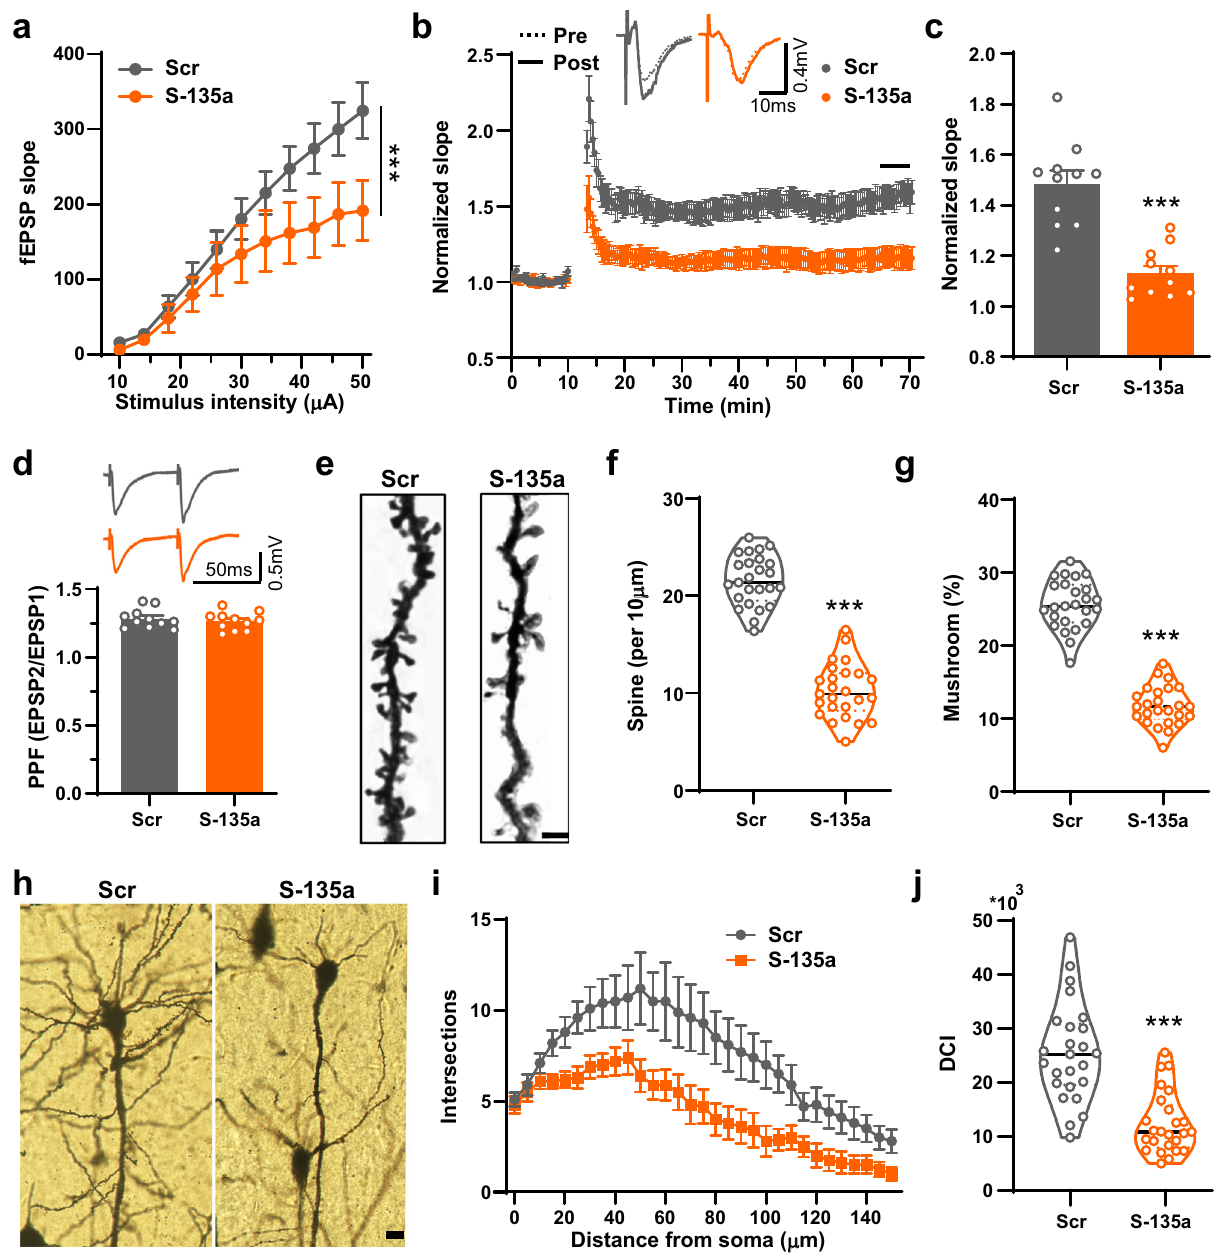
Fig. 4 Inhibition of miR-135a-5p induces the synaptic disorder in vivo. a The input – output (I – O) curve between stimuli intensity and fEPSP slope in the CA3 – CA1 projection of hippocampus in C57 mice after injection with S-135a or Scr virus as described above ( n = 11 slices from 5 mice for each group, two- way ANOVA, p < 0.0001). b The normalized fEPSP slope at hippocampal CA3-CA1 projection in S-135a or Scr injected mice before and after high- frequency stimulation (HFS). Representative traces of before (dash line, pre) and after (solid line, post) HFS ( n = 11 slices from 5 mice for each group). c Quantitative analysis of fEPSP slope at last 5 min as indicated by a black line in panel ( b ) ( n = 11 slices from 5 mice for each group, p < 0.0001). d The paired-pulse amplitude ratio (second trace/the fi rst trace) in CA3 – CA1 projection ( n = 11 for each group). e Representative Golgi staining images for the dendritic spines of C57 mice after injected with S-135a or Scr virus. Bar = 2 μ m. f , g Quantitative analysis of the spine density (per 10 μ m) ( f ) and percentage of mushroom spines ( g ) was performed ( n = 25 neurons from 5 mice for each group, p < 0.0001). h Golgi staining images shown the dendritic trees in S-135a or Scr injected mice. Bar = 20 μ m. i The Sholl analysis was performed to evaluate the dendritic complexity of S-135a or Scr injected mice ( n = 25 neurons from 5 mice for each group). j Dendritic Complexity Index (DCI) was calculated to evaluate the branching complexity of S-135a or Scr injected mice ( n = 25 neurons from 5 mice for each group, p < 0.0001). (Data are presented as mean ± S.E.M. and two-tailed t tests were used unless otherwise speci fi ed. Source data are provided as a Source Data fi le. *** p < 0.001 vs. Fig. 8k – m) and memory impairments (Fig. 7l – o) in AD model mice. Thus, blocking Rock2-mediated phosphorylation of Add1 effectively rescues AD-like synaptic and memory impairments in mice.